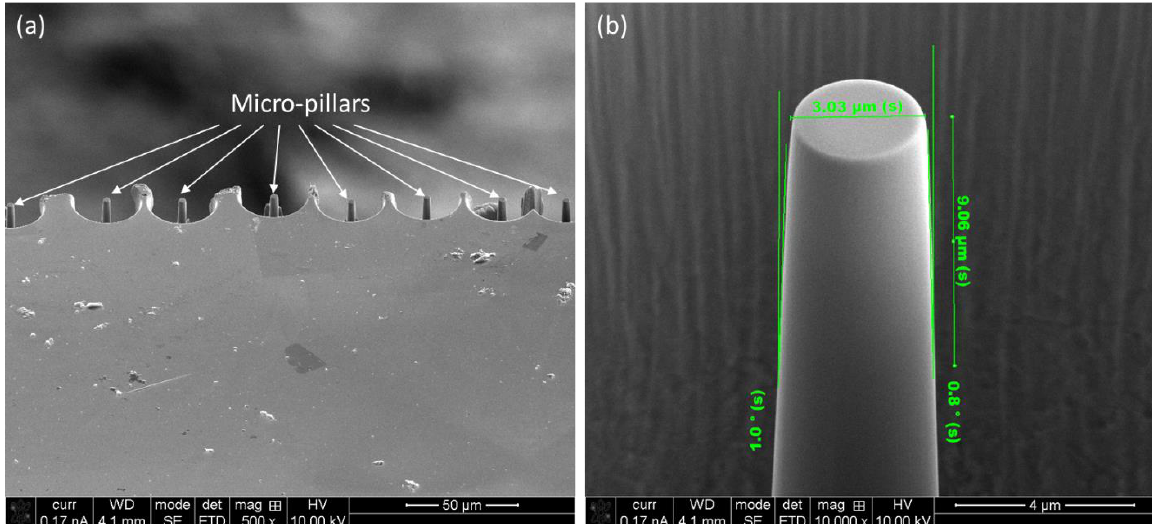
Figure 2. ( a ) A series of FIB-SEM prepared micro-pillars in the middle of Ø 30 µ m pit on the recast layer, and ( b ) high magnification images on one of the micro-pillars together with dimensions.